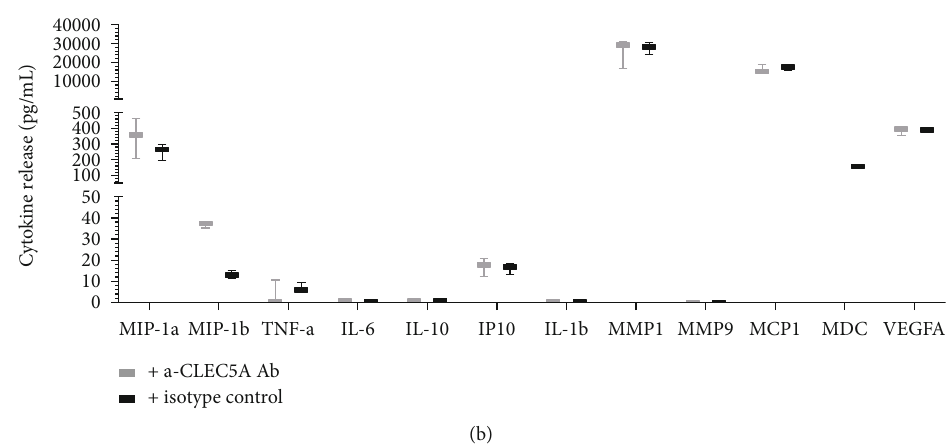
Figure 2: Monoclonal α -CLEC5A Ab triggers a time-dependent cytokine secretion from U937 WT but not from U937 CLEC5A KO cell line. (a) PMA-di ff erentiated WT U937 cells were transferred on culture plates previously coated with 20 μ g/mL of α -CLEC5A Ab (grey symbols) or isotype ctrl (black symbols). Cell culture supernatants harvested after 16 h (upper panel), 24h (middle panel), and 48 h (bottom panel) were tested for the indicated cytokines with MSD or ELISA kits. (b) PMA-di ff erentiated U937 KO cells were incubated 48h on culture plates previously coated with 20 μ g/mL of α -CLEC5A Ab (grey symbols) or isotype ctrl (black symbols). Cell culture supernatants were tested for di ff erent cytokines with MSD or ELISA kits. Values represent the mean and SD calculated from three technical replicates/condition; ∗ p < 0 : 033 , ∗∗ p < 0 : 002 , and ∗∗∗ p < 0 : 001